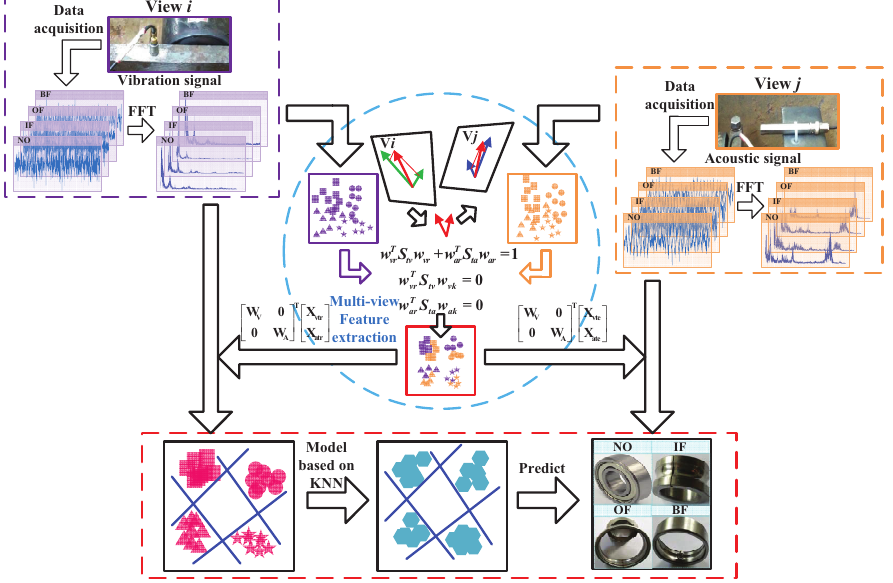
Figure 1. The framework of the proposed DAML